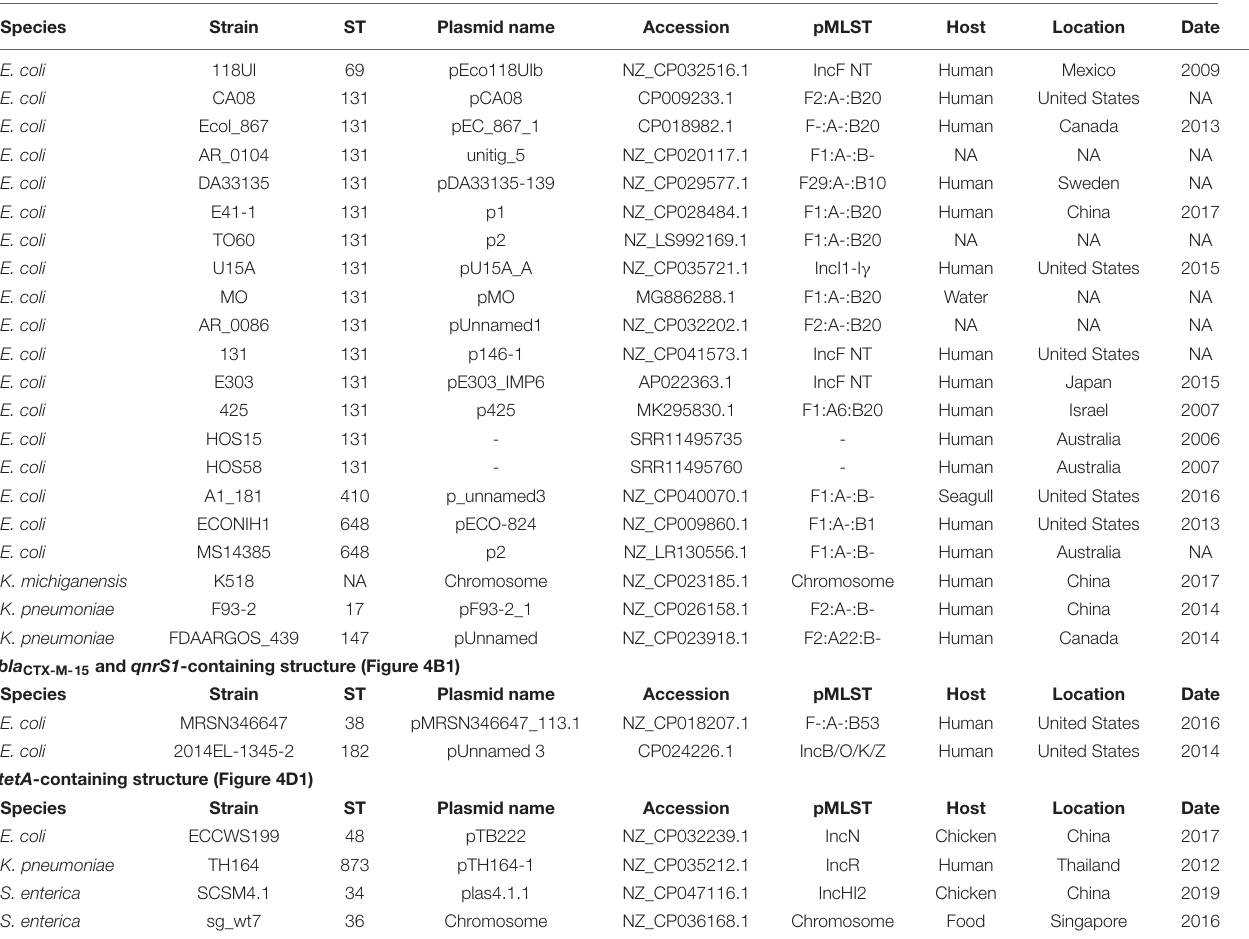
TABLE 2 | Summary of BLAST hits (100%) to AMR regions found in this collection. IS 26 flanked class 1 integron, chromate resistance and macrolide inactivation structure (Figure 4A1)